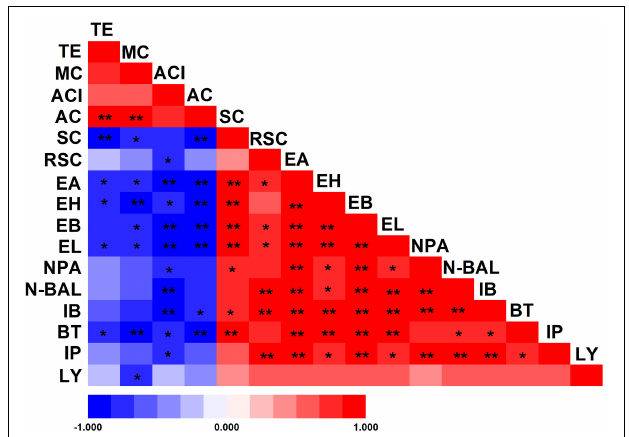
FIGURE 5 | Pearson’s correlation coefficients between physicochemical properties of fermented grains and volatile compounds of liquor. *Correlation is significant at the 0.05 level. **Correlation is significant at the 0.01 level. TE, temperature; MC, moisture content; ACI, acidity; AC, alcohol content; SC, starch content; RSC, reducing sugar content; EA, ethyl acetate; EH, ethyl hexanoate; EB, ethyl butyrate; EL, ethyl lactate; NPA, n-propanol; N-BAL, n-butanol; IB, isobutanol; BT, butanol; IP, isopentanol; LY, liquor